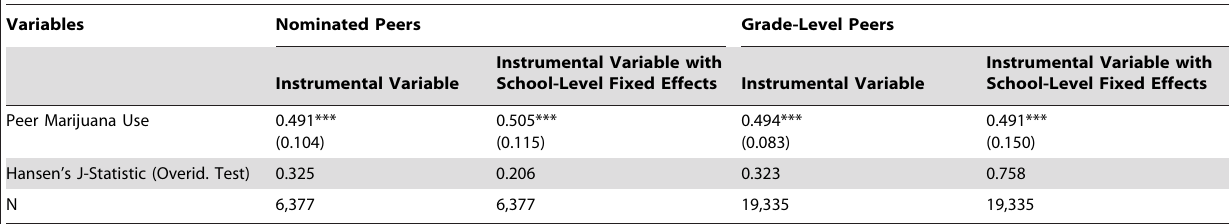
Table 3. Determinants of marijuana use